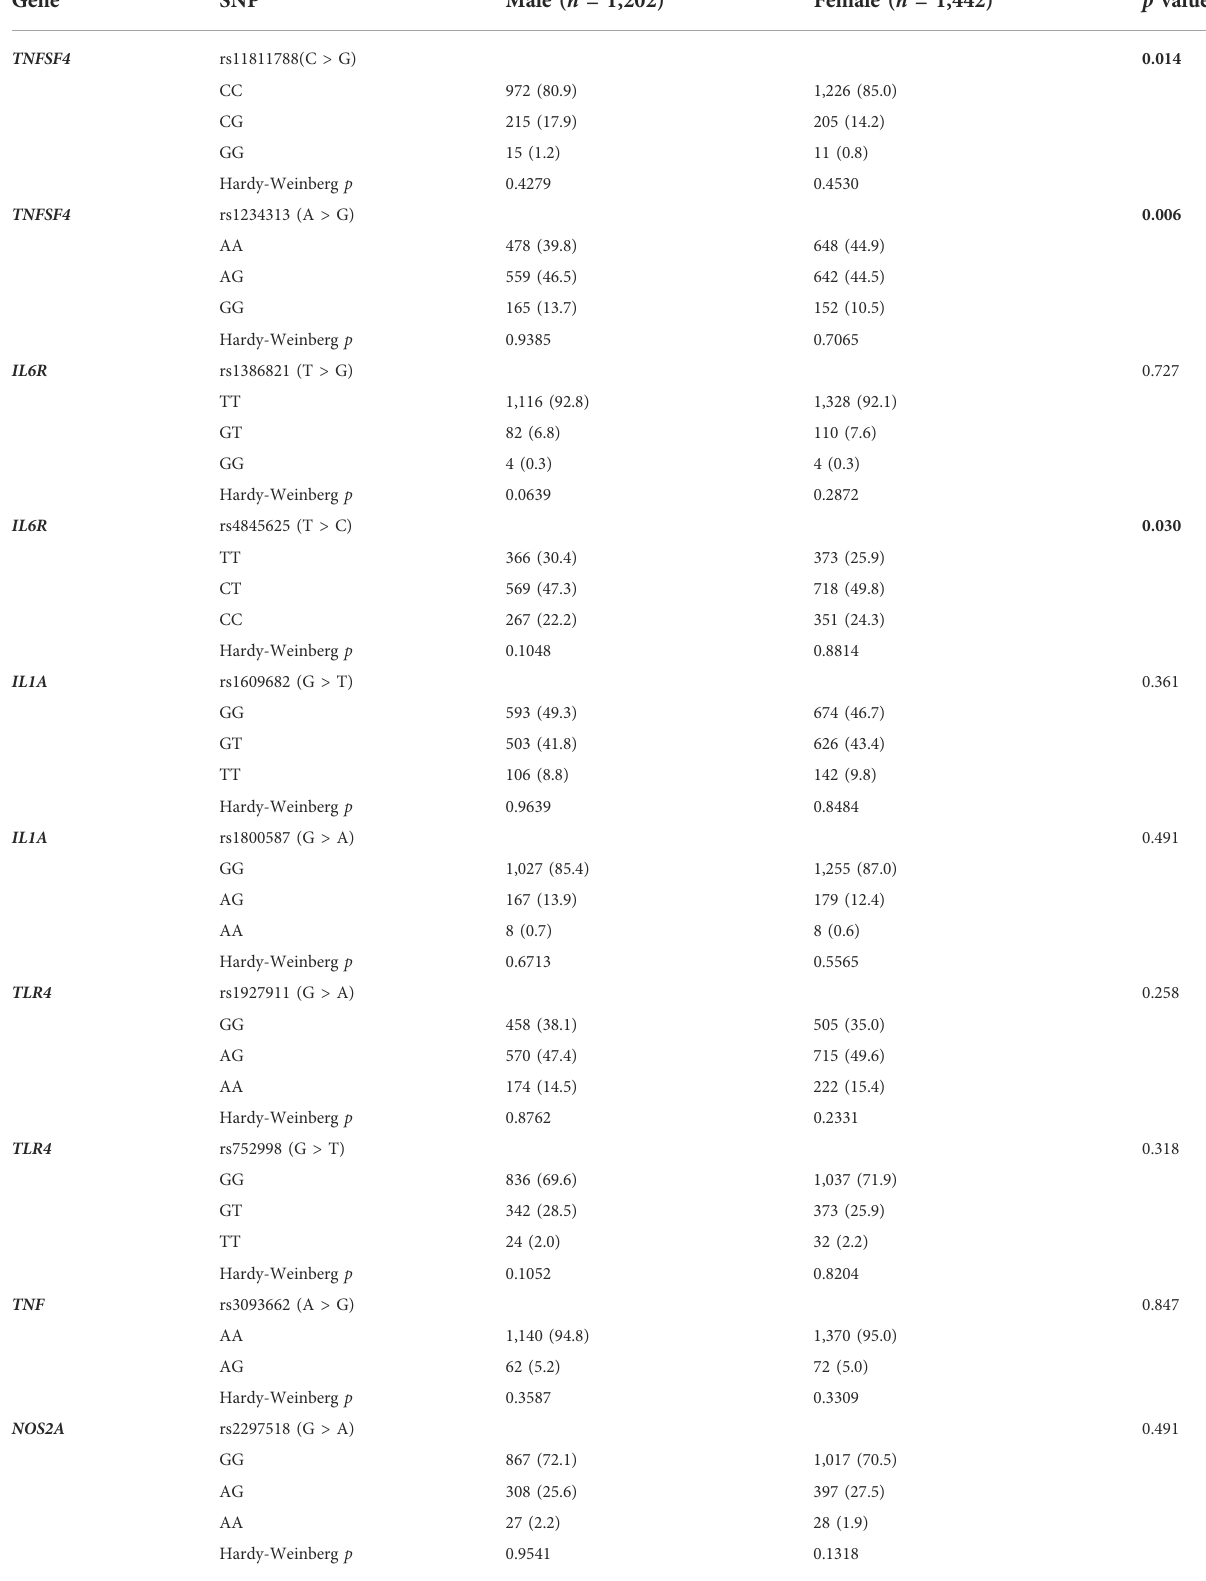
TABLE 1 Genotype distributions of 17 SNPs in 10 genes between different